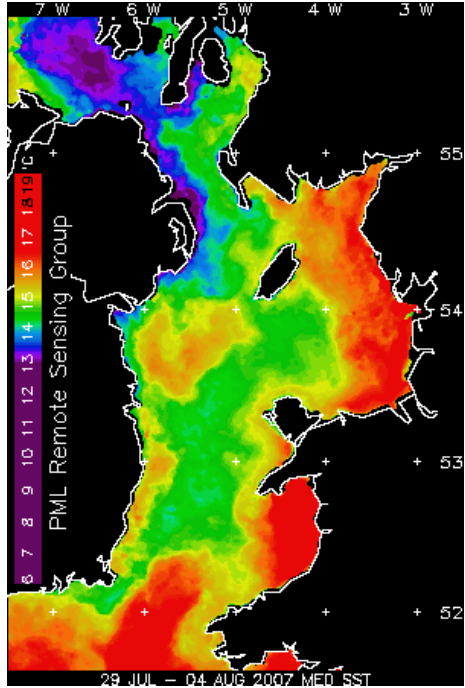
Fig. 9. Sea surface temperature weekly composite image between the 29 July and 4 August 2007. Image courtesy of NEODAAS, via the NOC Coastal Observatory.